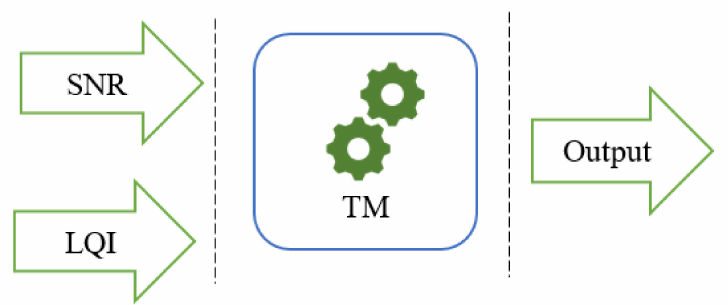
Figure 3. Triangle metric based link quality estimation in underwater networking.